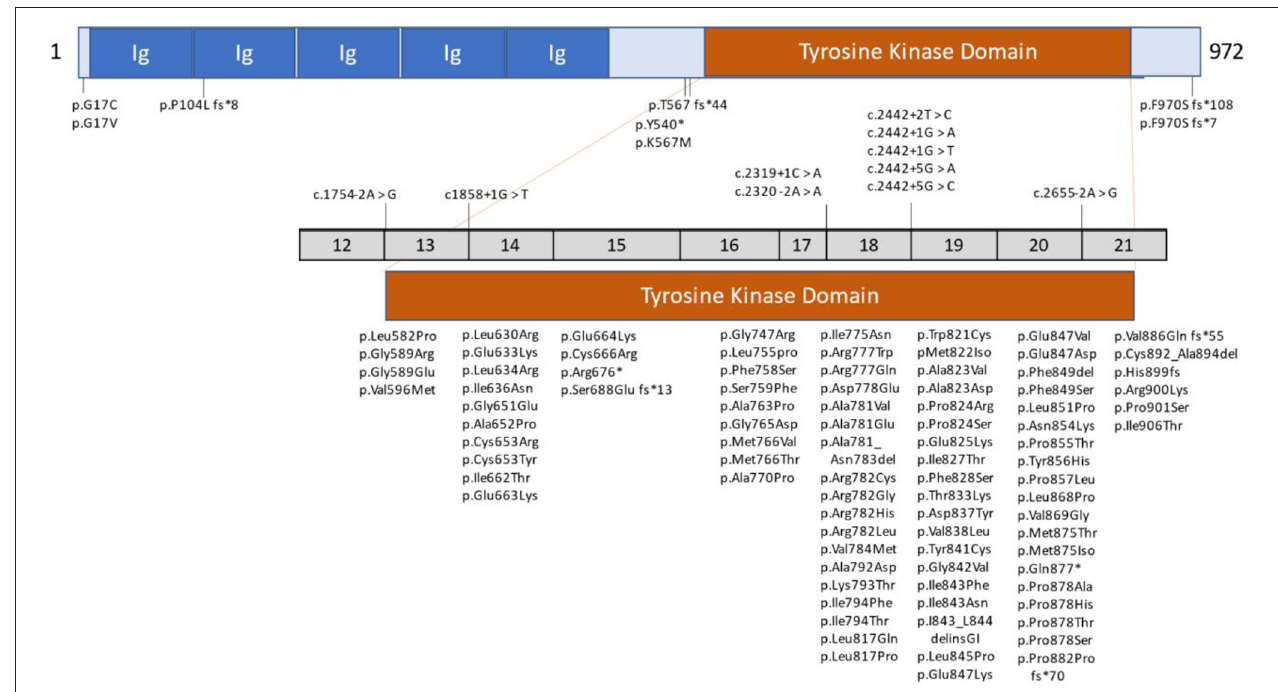
FIGURE 1 | Schematic graph of the CSF1R protein and overview of CSF1R mutations identified in patients with CSF1R -related leukoencephalopathy. CSF1R , colony-stimulating factor 1 receptor; Ig, immunoglobulin domain. Revised/updated version reprinted with permission from (